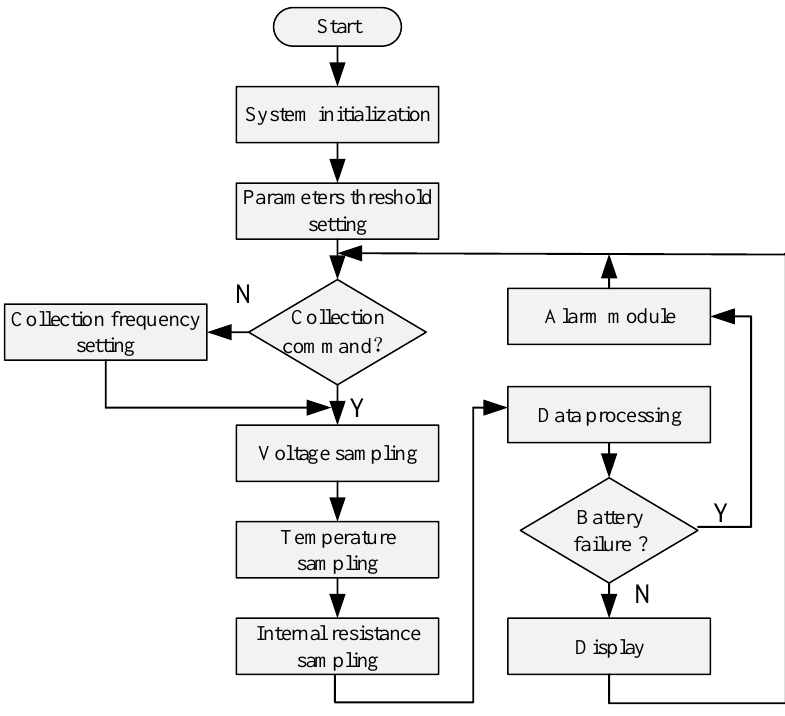
Figure 8. Flow chart of parameter acquisition software.